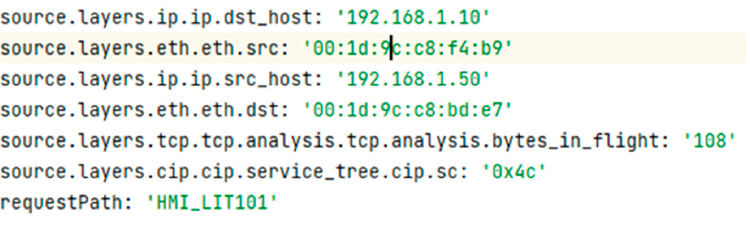
Figure 10. Features Extracted from the Decoder.